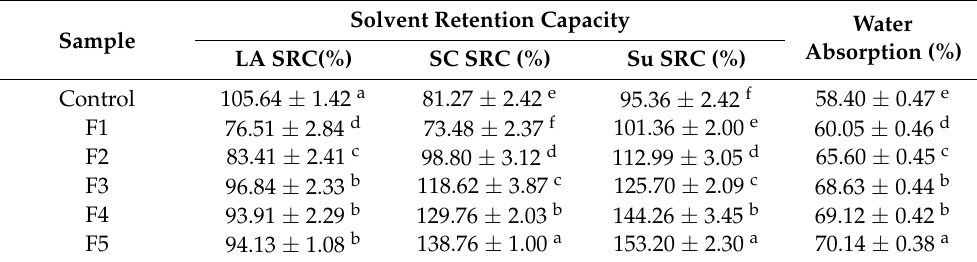
Table 2. Solvent retention capacity and water absorption of wheat flour.